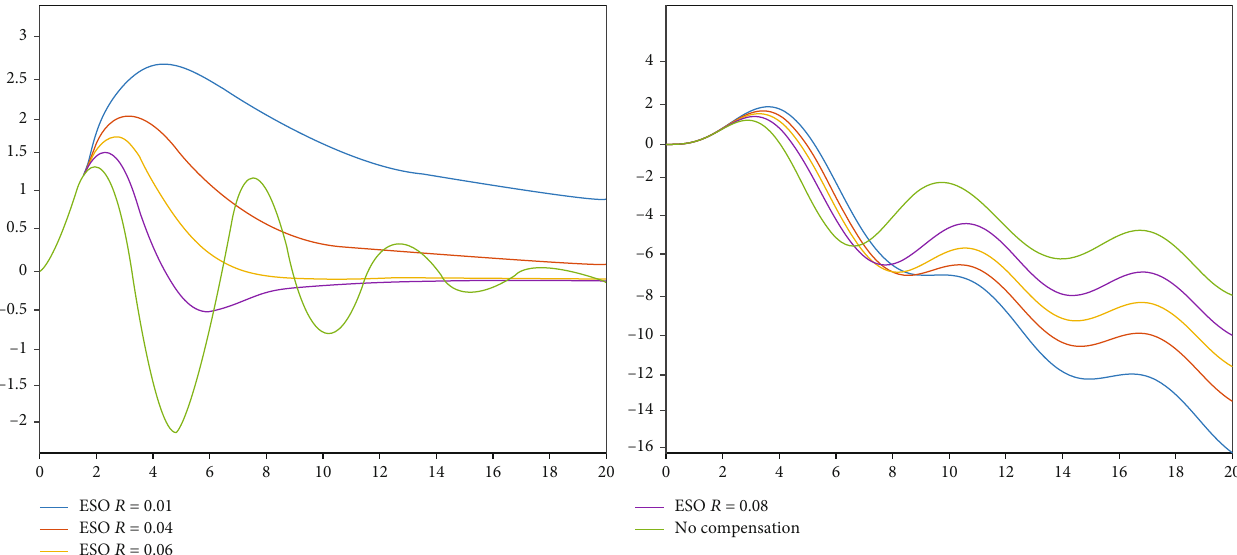
Figure 19: E ff ect of initial pointing error on dimensionless miss distance under step and wave disturbance.